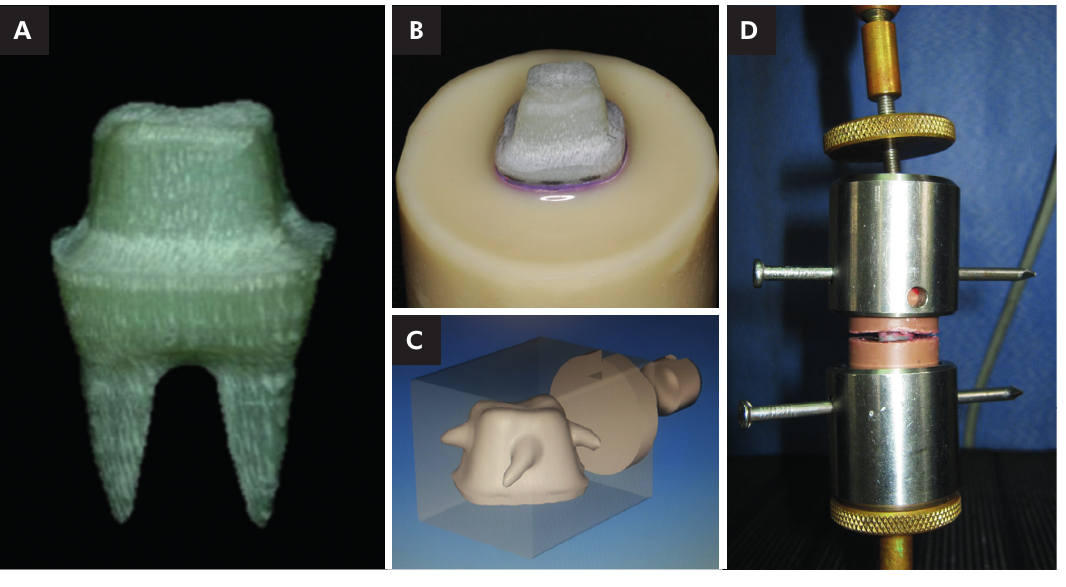
Figure 1. Preparation for total crown in a right maxillary second molar milled in G10 (A). Epoxy resin base was used for periodontal ligament simulation (B). Design of the crown milled by CAD/CAM (C). Sample in the universal test machine for the retentive strength test